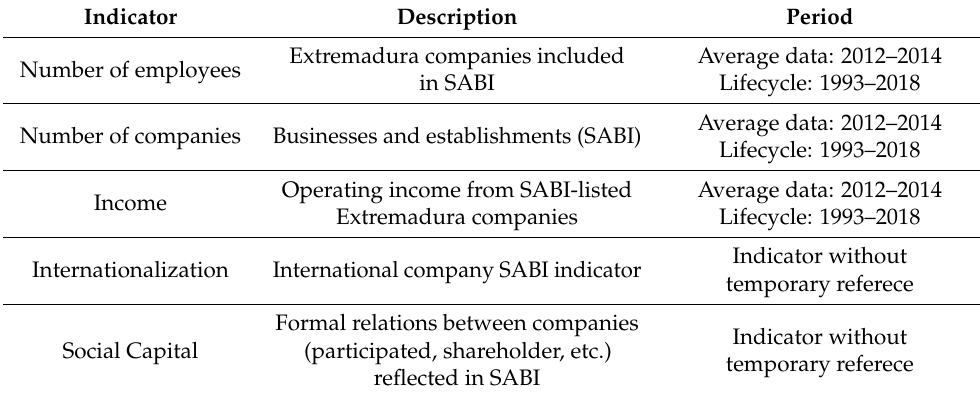
Table 4. Description of